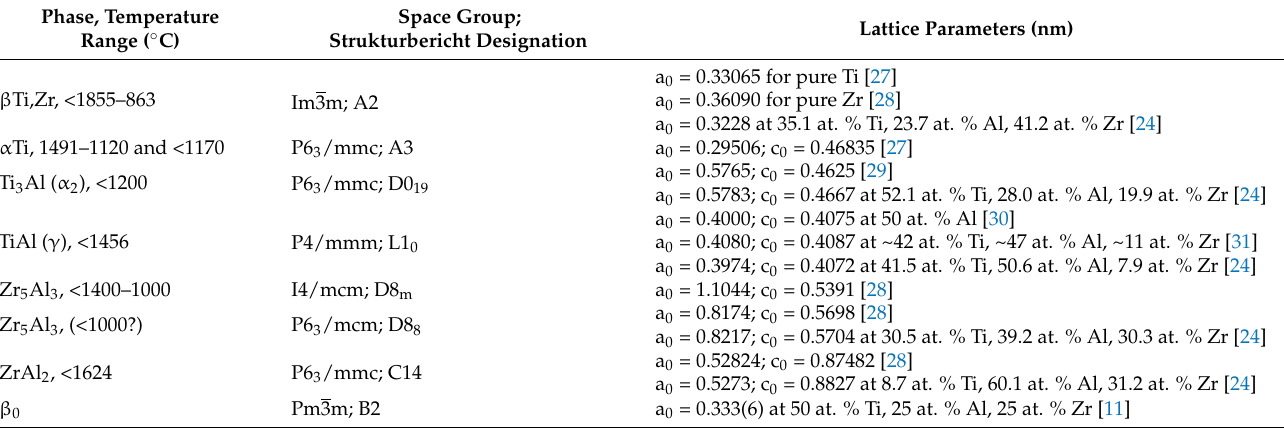
Table 1. Crystallographic data of solid